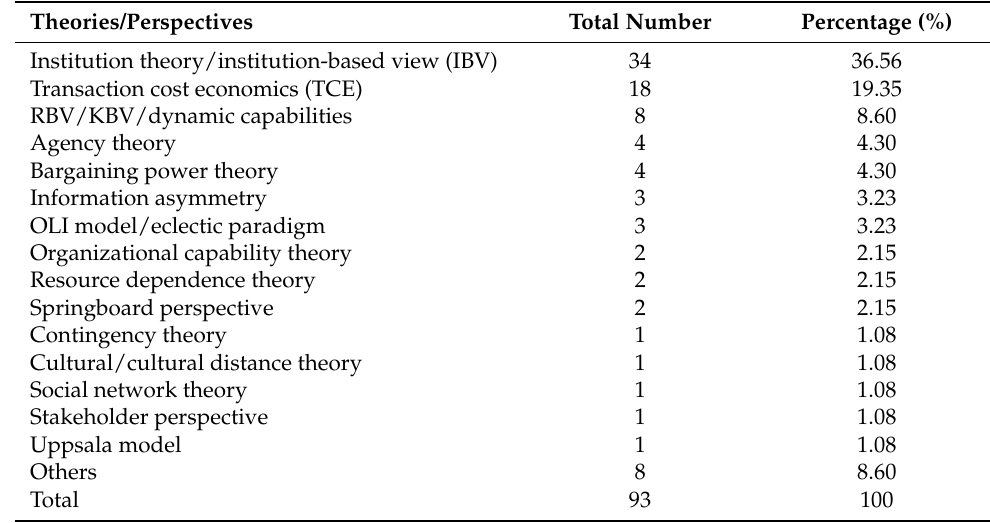
Table 2. Theories/perspectives of entry mode choice under volatile environments used in selected journal articles.